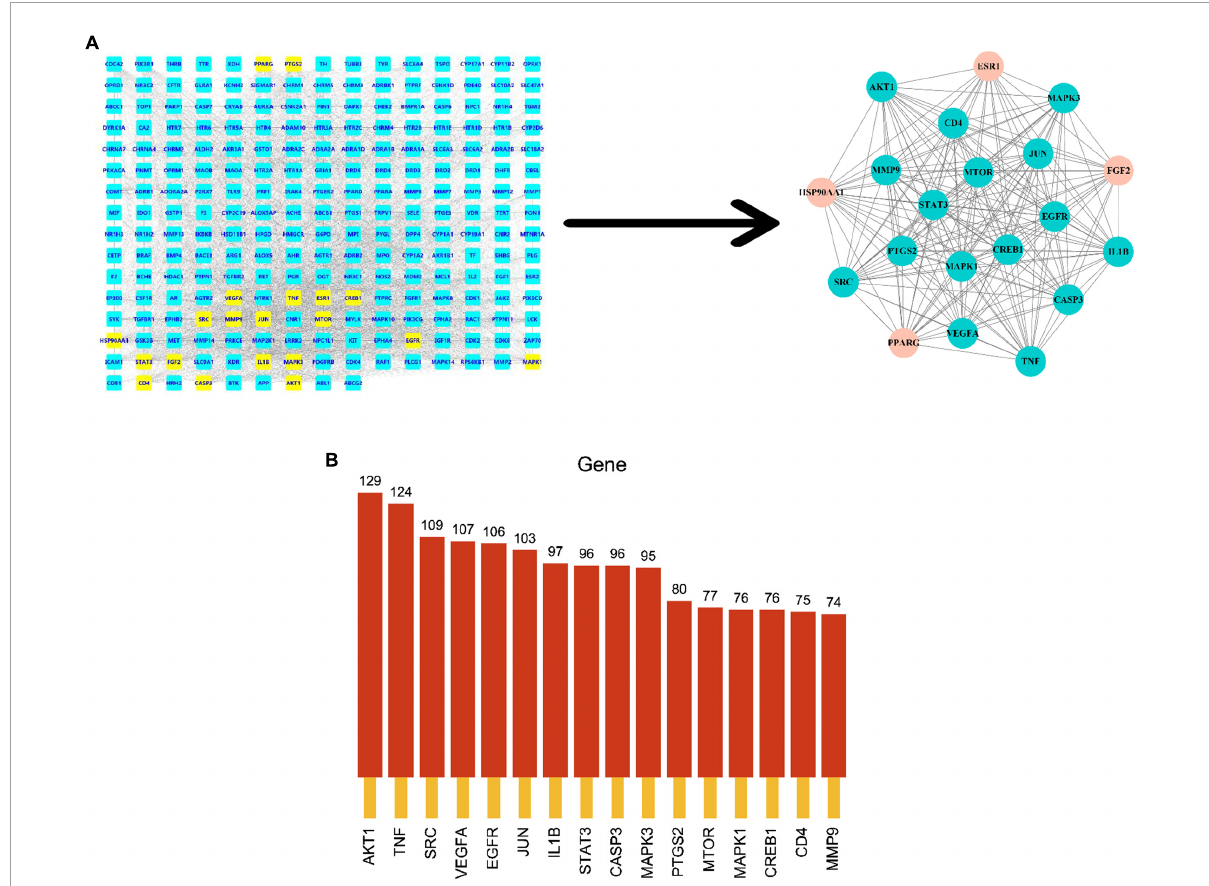
FIGURE6 Screening of core targets. (A) Shows the process of secondary median screening, and the dark green part indicates the core target genes obtained from the screening. The core targets after the secondary screening were arranged in the order of the degree values from the largest to smallest, and the bar graph was drawn to obtain (B)